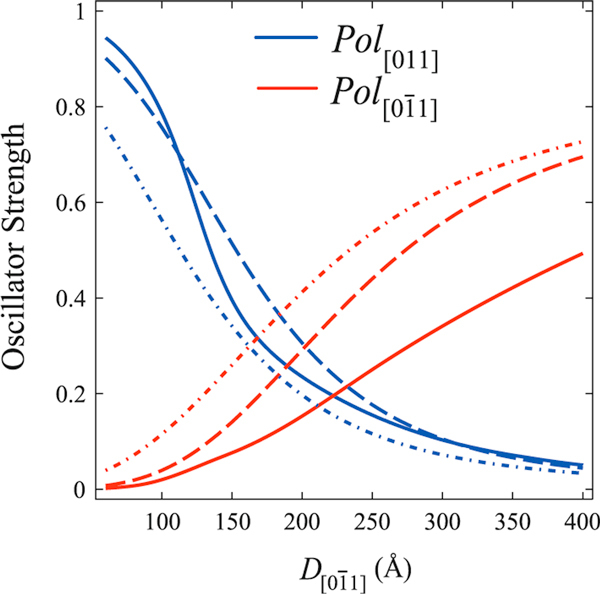
Calculated oscillator strengths for crossed linear optical polarizations for a strained system of two coupled QDs with different inter-dot distances d = 160 Å (dashed line), 330 Å (dashed-dotted line) and infinite (solid line) corresponding to a single (isolated) QD. Here was taken a lateral size D[011] = 350 Å and a strain order factor ε|| = - 0.2%.